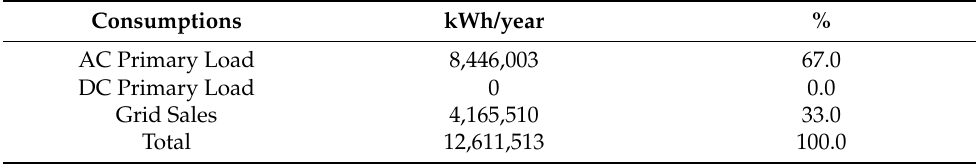
Table 3. Energy demand and grid export.